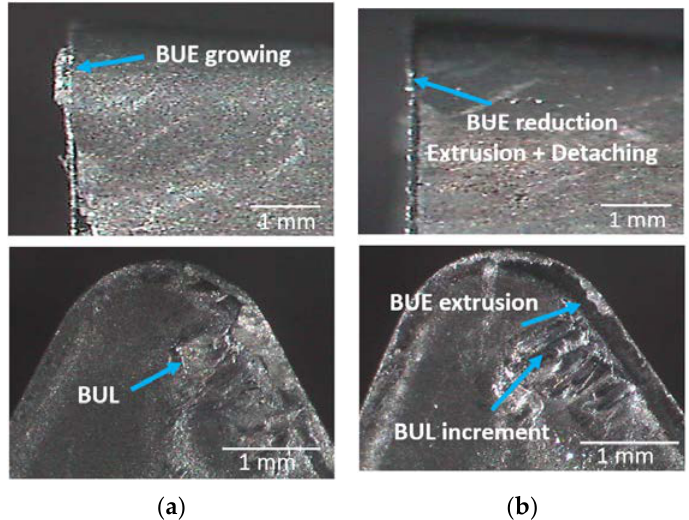
Figure 8. SOM images of the flank and the rake tool face for v c = 80 m/min and f = 0.15 mm/rev; ( a ) R1; ( b ) R3.